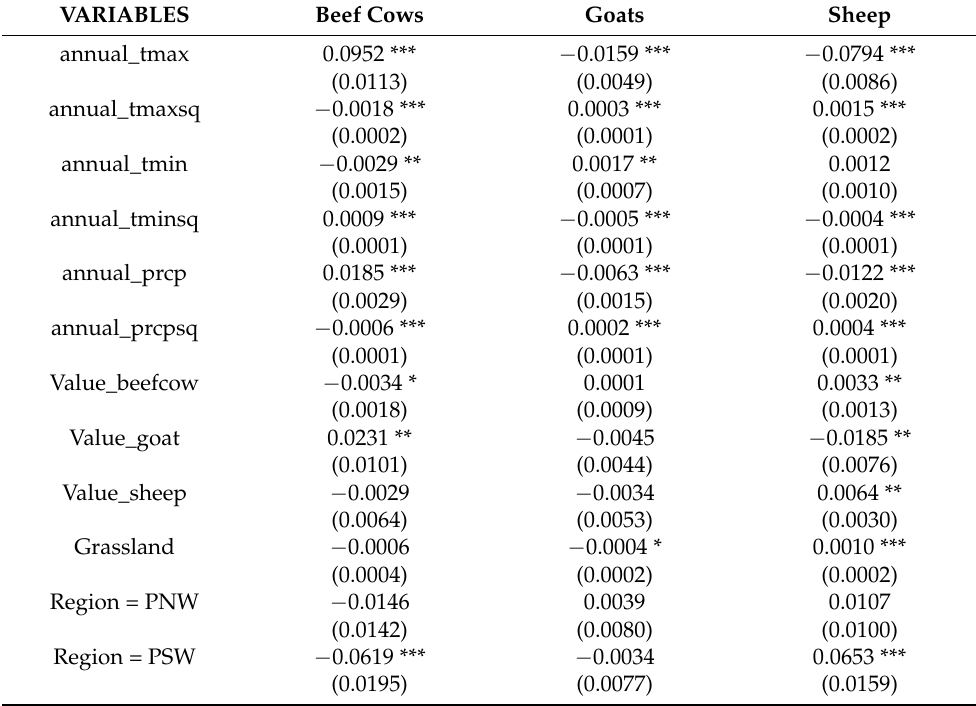
Table 7. Average marginal effect on land share in Western